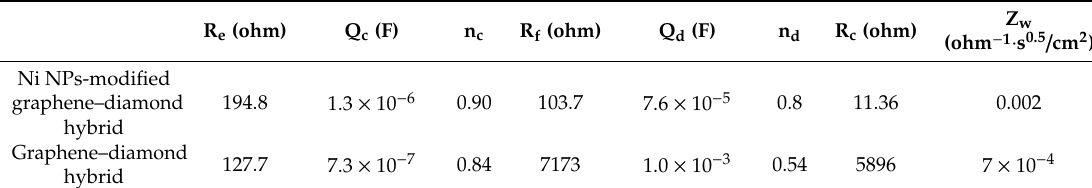
Table 1. The fitting parameters of the fitting equivalent circuit.